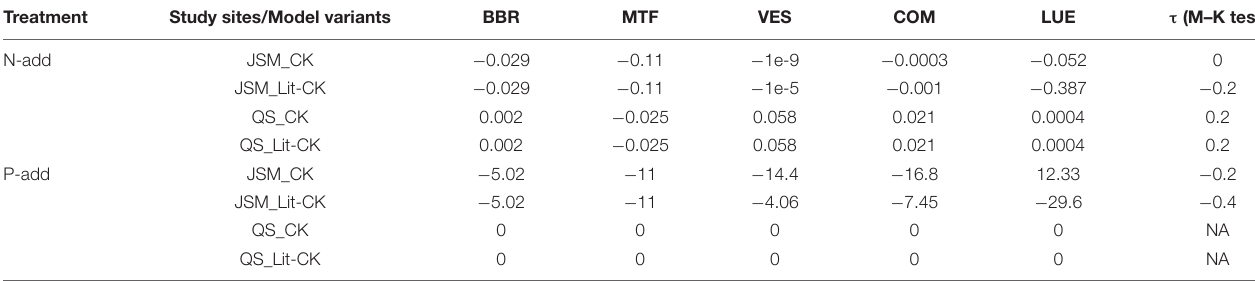
TABLE 5 | Simulated soil respiration responses (g C/m 2 ) of model scenarios at all study sites. Treatment Study sites/Model